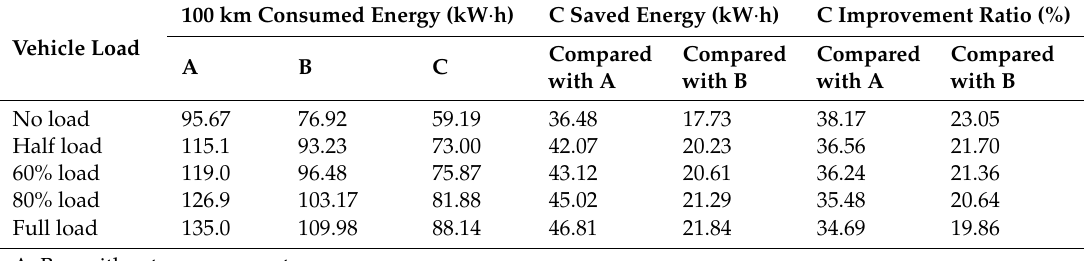
Table 1. km performance comparison between buses with di ff erent brake